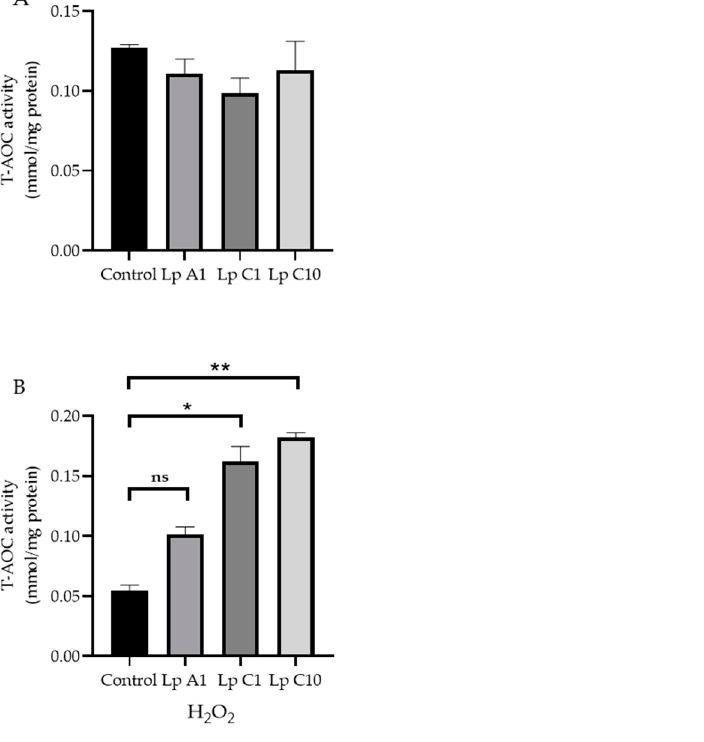
Figure 6. Total antioxidant capacity (T − AOC) activities in bovine jejunum epithelial cells treated with Lactiplantibacillus plantarum A1, C1 and C10, under conditions without ( A ) or with 200 µ mol/L H 2 O 2 ( B ). Values are means ± standard error; ns, not significant; * p < 0.05, ** p < 0.01. Lp = Lactiplantibacillus plantarum